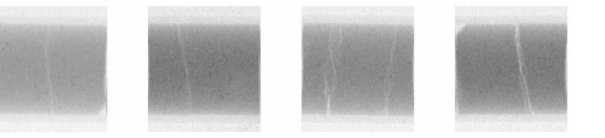
Figure 6. Cracks in fuel pellets. The pellets are enclosed in zirconium-based tubes of approximately 10 mm outer